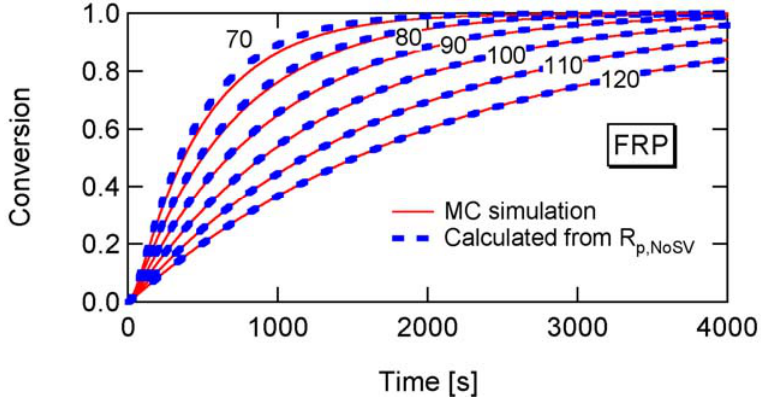
Figure 16. Conversion development of the conventional FRP with various particle